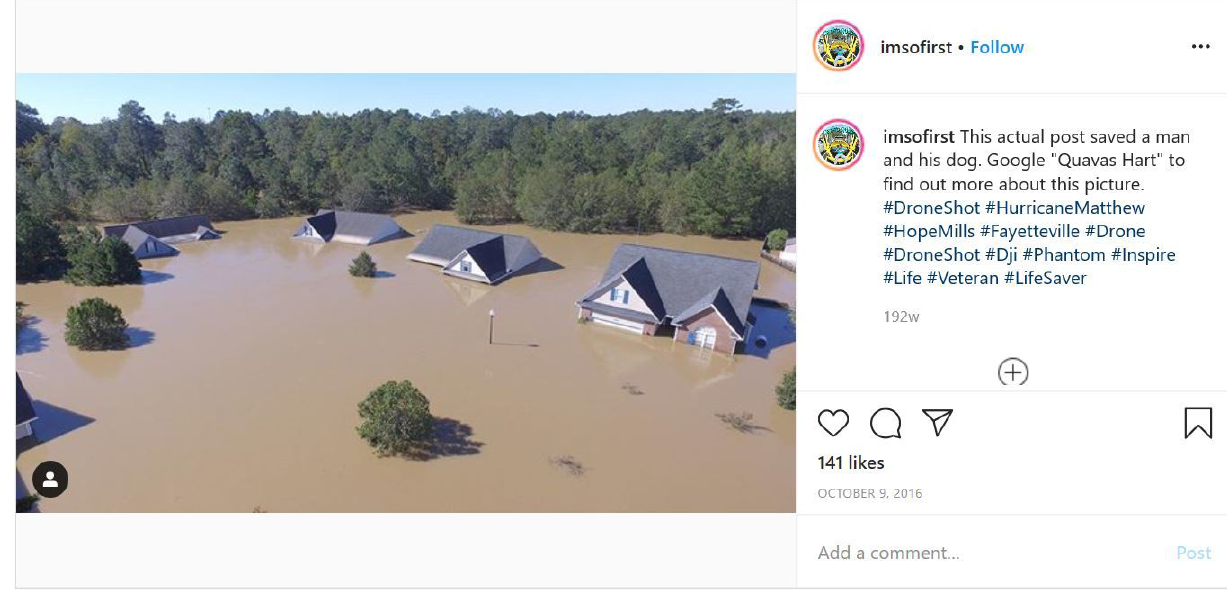
Figure 1: Flooding after Hurricane Matthew captured by Quavas Hart, Instagram, Oct 9. 2016. Source: https://www.instagram.com/p/BLWOBmlAI9e/.